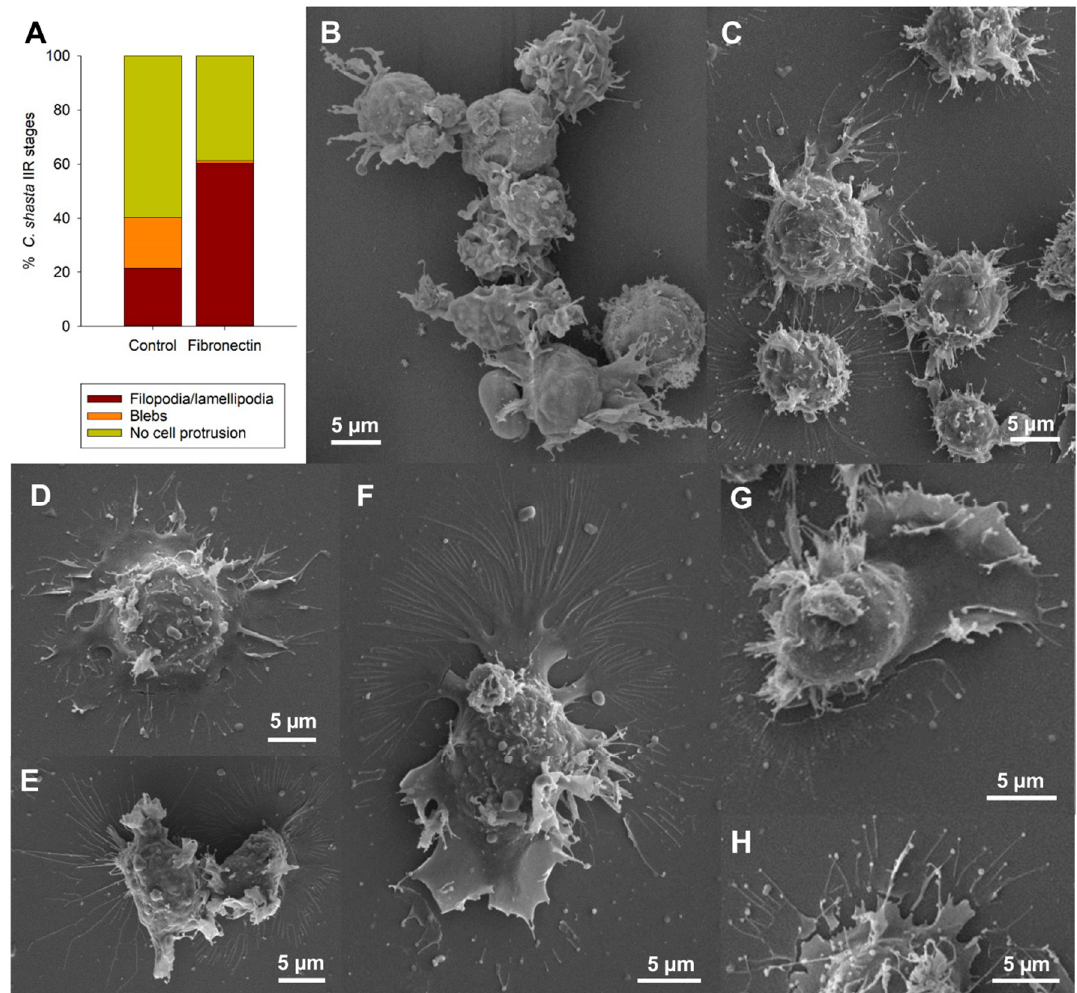
Figure 5. Adhesion experiment with Ceratonova shasta genotype IIR stages collected from ascites of rainbow trout. ( A ) Percentage of stages exhibiting different cell protrusions on control non-coated slides and on fibronectin coated slides. ( B ) Control stages showing a 3D distribution of filopodia and lamellipodia. ( C ) Stages on fibronectin showing a strong adhesion for the surface with a 2D distribution. ( D ) Stages on fibronectin with radially distributed lamellipodia with small filopodia on the external margin. ( E ) Two stages partially attached, one of them with long and thin filopodia. ( F , G ) Polarized stages on fibronectin with sheet-like lamellipodia on one pole and long and ramified filopodia on the other pole. ( H ) Detail of slightly thickened filopodia tips of an adhesive stage. B – H ,